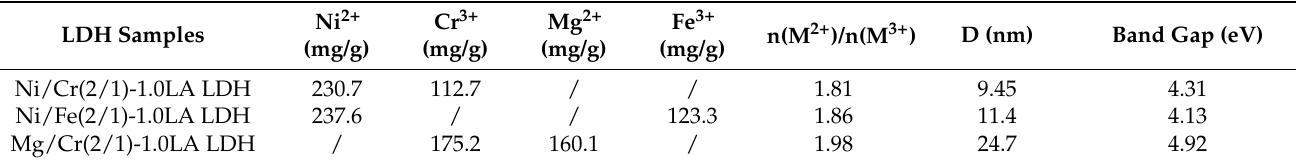
Figure 7. Photocatalytic degradation of MO over ( a ) Ni/Fe(2/1) − 1.0LA LDH and ( b ) Mg/Cr(2/1)– 1.0LA LDH. Table 2. Analysis for Ni/Cr(2/1) − 1.0LA LDH, Mg/Cr(2/1) − 1.0LA LDH, and Ni/Fe(2/1) − 1.0LA